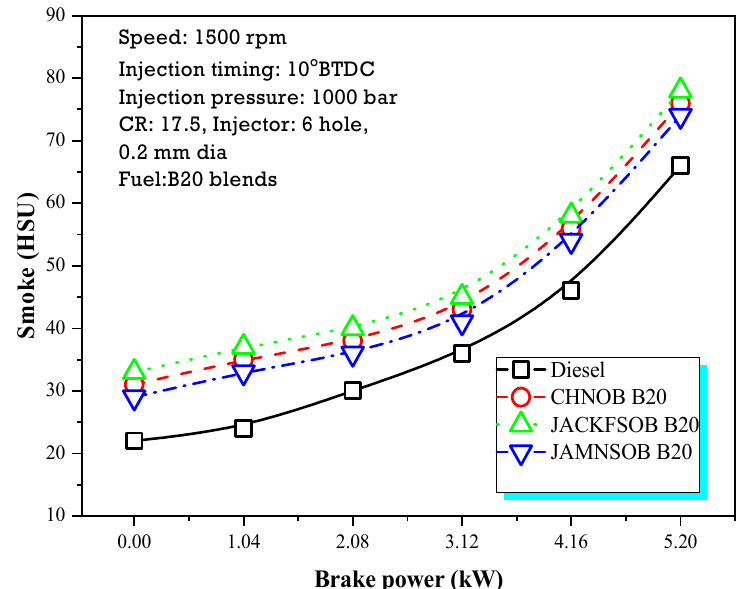
Figure 7. Variation of SE vs. BP.